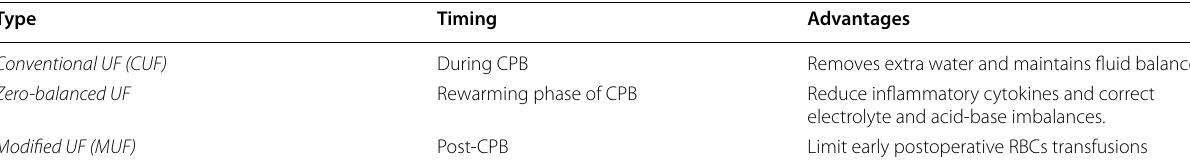
Table 3 Types with advantages of various ultrafiltration (UF) techniques Type Timing